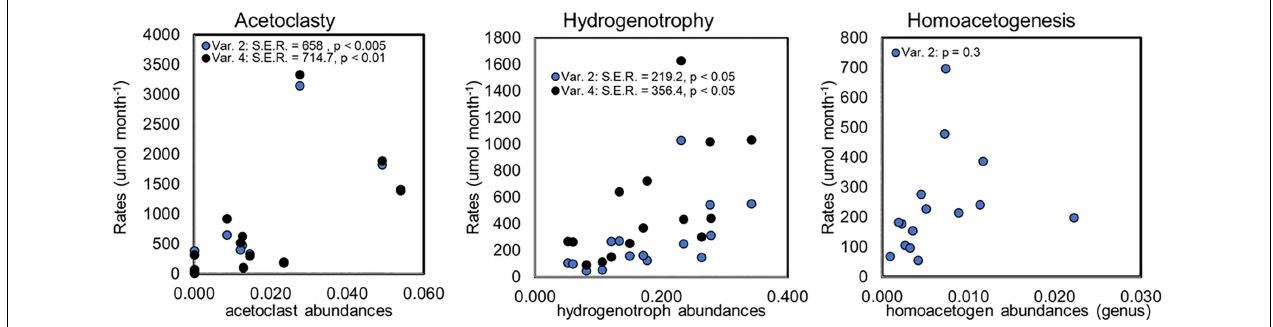
FIGURE 7 | Regression analyses comparing rates with relative microbial abundances for model variants 2 (Var. 2) and 4 (Var. 4). Points are plotted as the median rates calculated for the nearest time-point at which relative microbial abundances were measured across all habitat types. Homoacetogen abundances were considered at the genus-level as described in the text. Regression results are indicated within each panel, where S.E.R. indicates the standard error of the regression. Homoacetogenesis is excluded in variant 4 and is not included on the